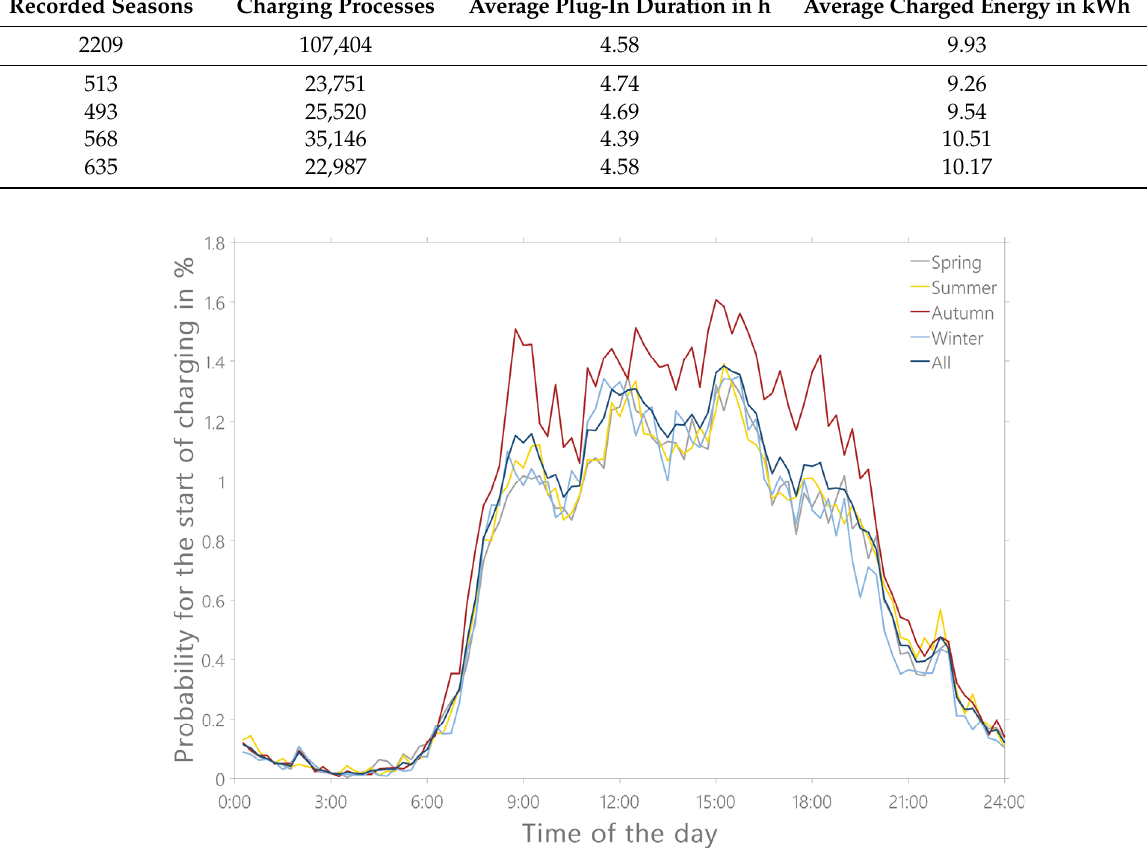
Figure 7. Probabilities for the start of a charging process classified by season in 15 min